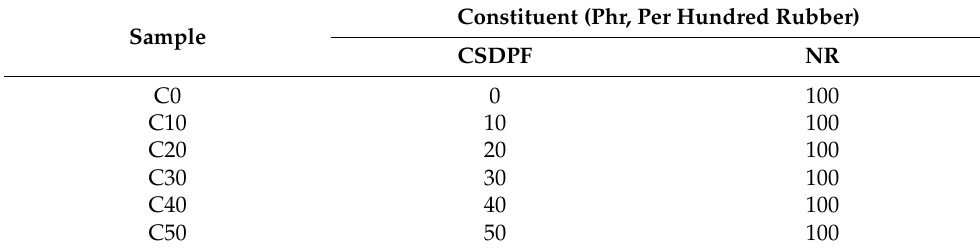
Table 1. Formulation of the CSDPF/NR